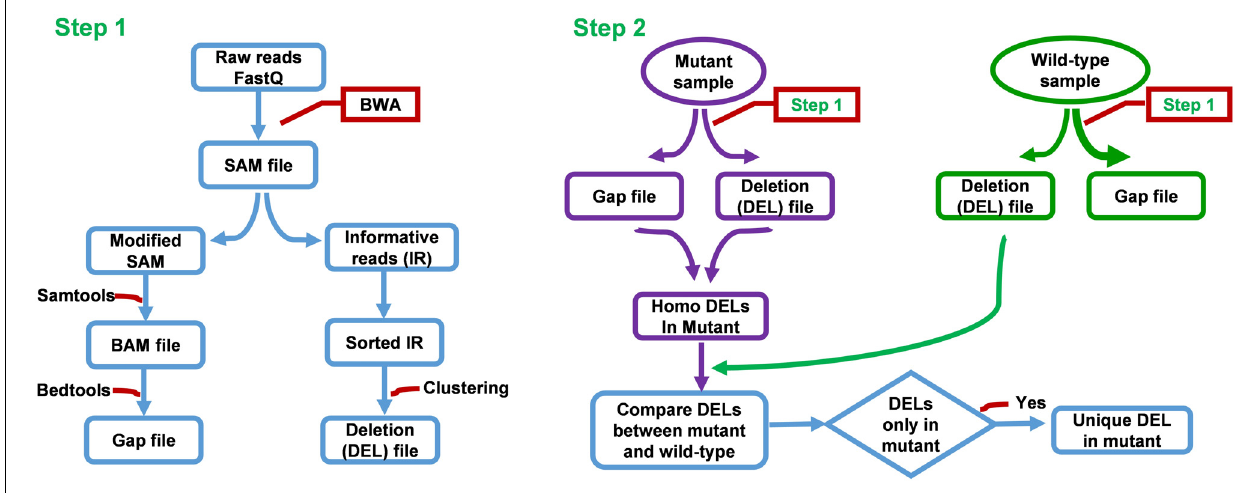
FIGURE 2 | Flow chart of FNBtools. Step 1 aligns NGS reads to the reference genome. Step 2 compares the deletions between the mutant sample and the wild-type or the control